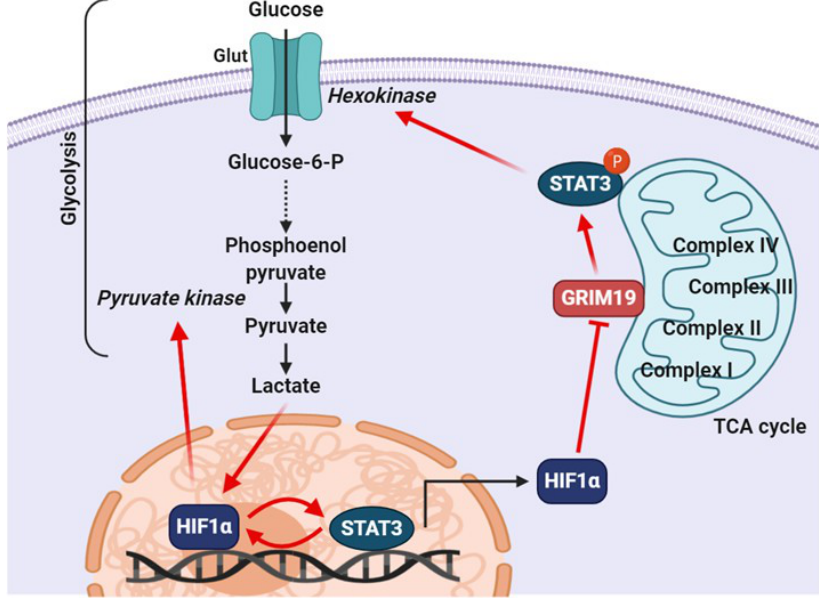
Figure 4. Proposed mechanism of constitutively active STAT3 in cancer cell glycolysis. Pyruvate produced via glycolysis is metabolized to lactate rather than to acetyl-CoA through lactic acid fermentation, and lactate can support the post-translational stabilization of HIF-1 α in cancer cells. HIF-1 α regulates PKM2 expression by binding to the hypoxia-response elements located within the PKM2 gene. Upregulation of PKM2 expression results in the conversion of phosphoenolpyruvate